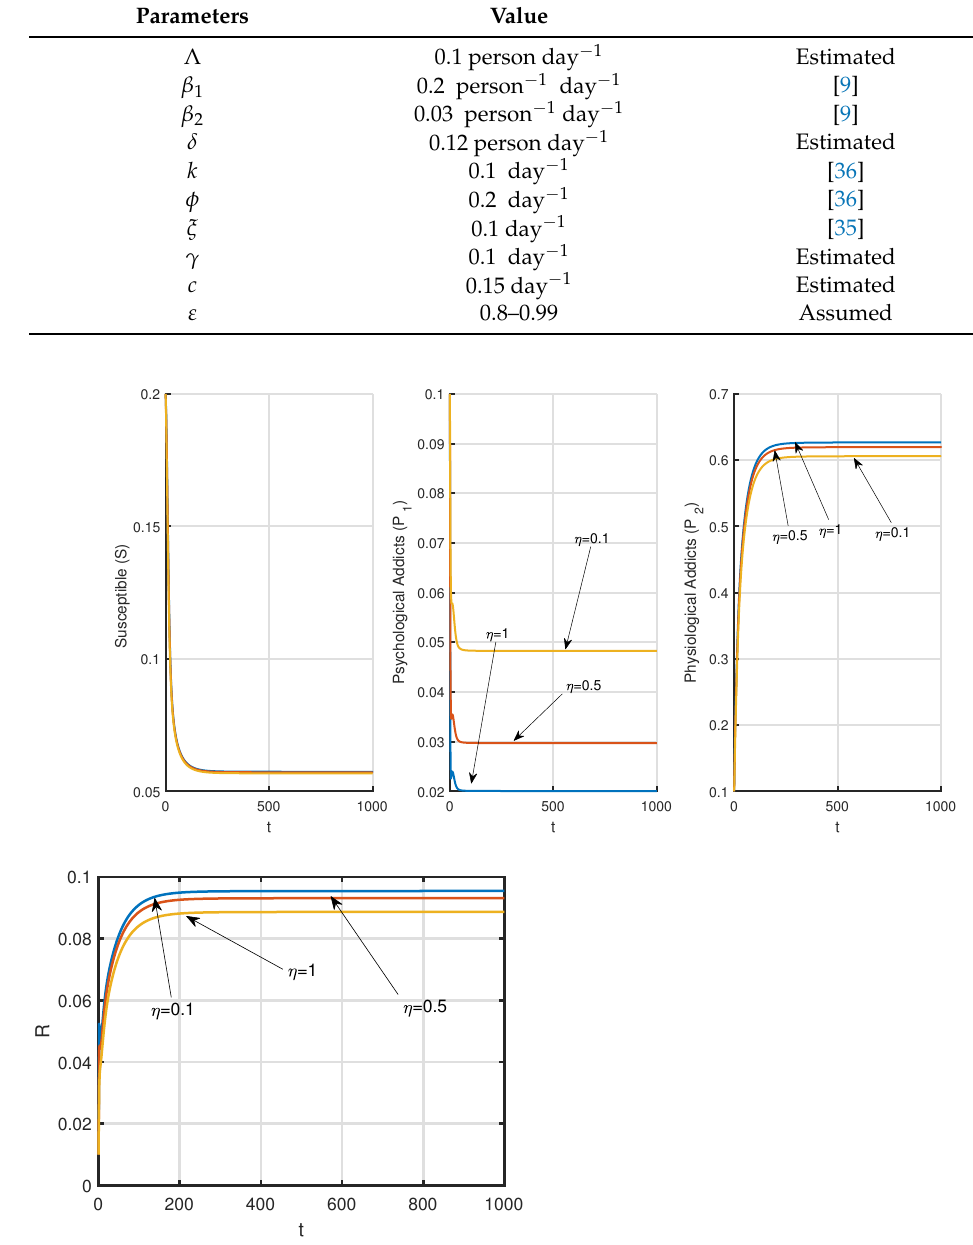
Figure 11. Variation of time series of system (26) with different control η corresponds to Table